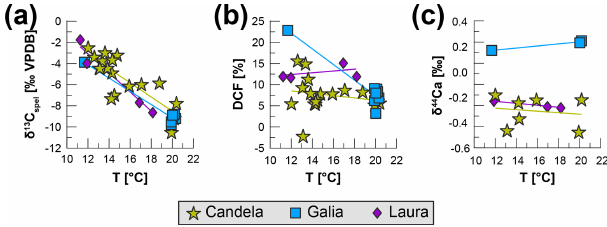
Figure 5. Stalagmite proxies vs. temperature, colour-coded by sta- lagmite. (a) δ 13 C spel ; (b) DCF; (c) δ 44 / 40 Ca. The corresponding paleo-temperatures are linearly interpolated from the Iberian Mar- gin sea surface temperature (SST) record by Darfeuil et al. (2016) without considering chronological and measurement uncertainties in either